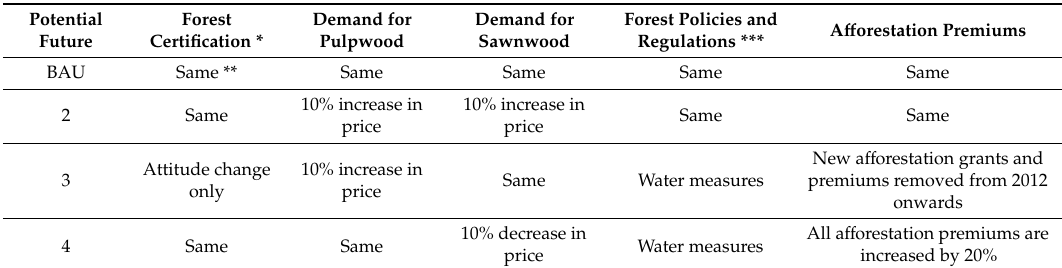
Table 3. Summarising the potential futures (rows) in terms of the key factors (columns) for the NM case study area (CSA). Source: Corrigan